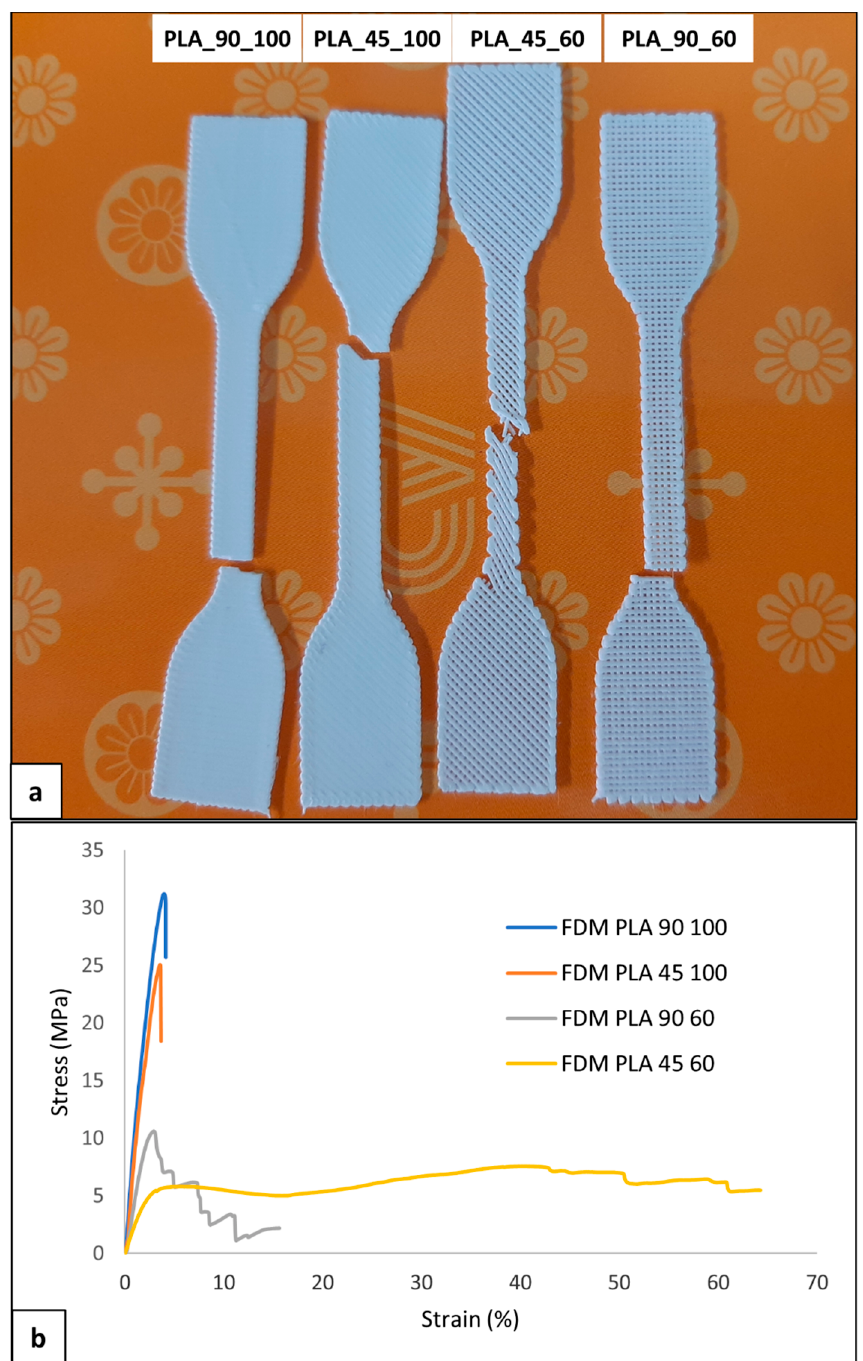
Figure 10. Mechanical characterization of PLA samples: ( a ) representative picture of broken samples and ( b ) stress-strain curves of the four kinds of developed samples.